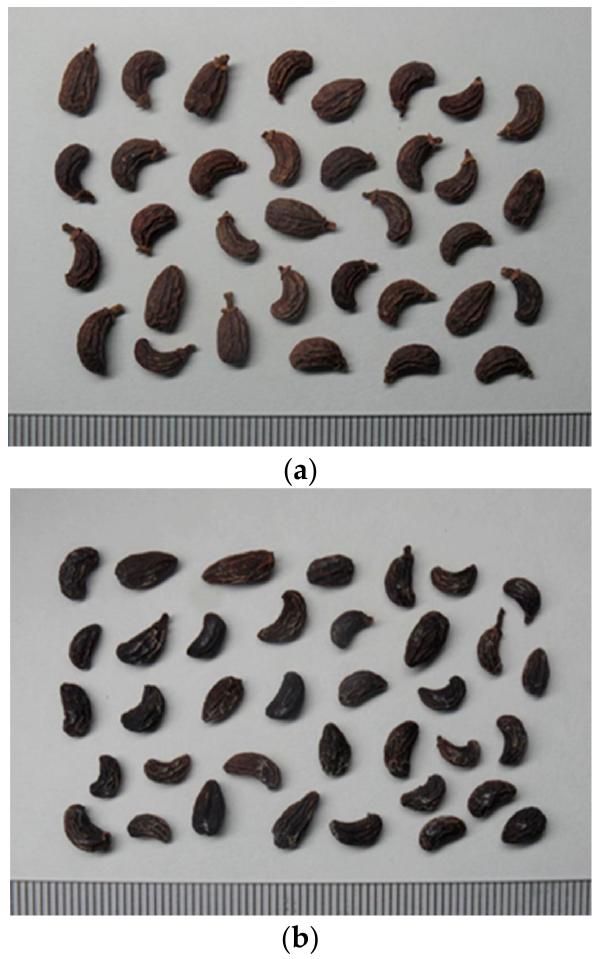
Figure 1. Comparison of FLL photographs before ( a ) and after ( b ) concoction.